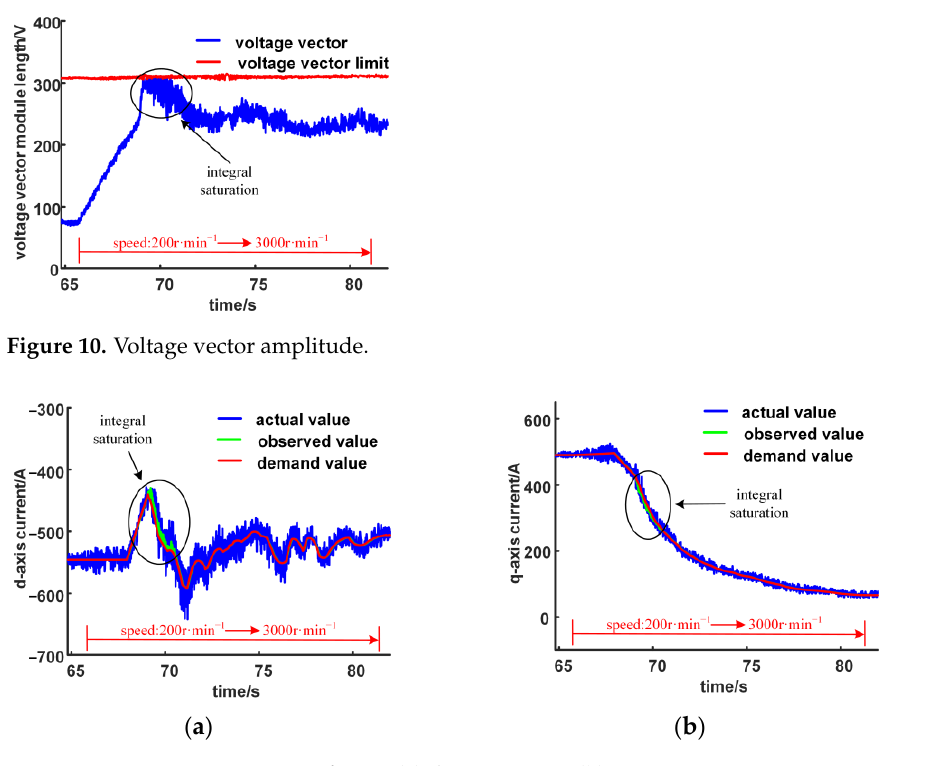
Figure 11. Dq-axis current waveforms: ( a ) d-axis current; ( b ) q-axis current.